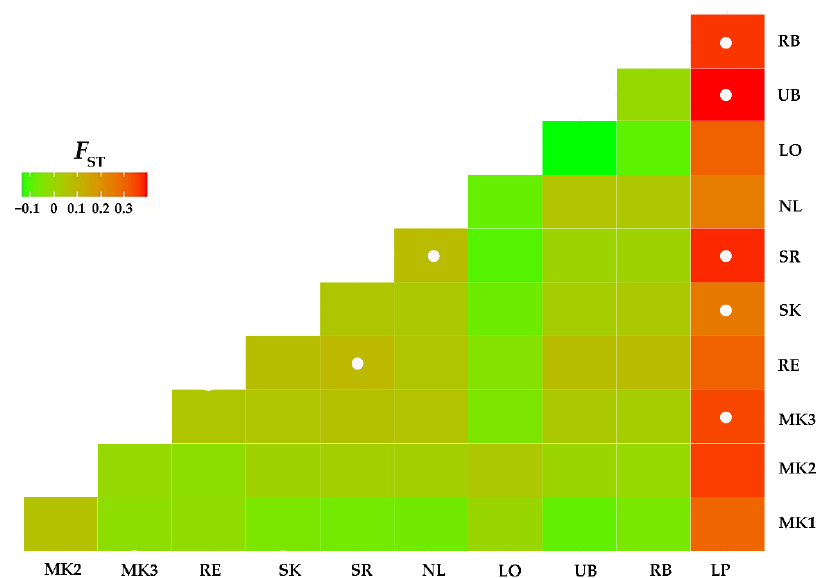
Figure 4. Heatmap for the pairwise F ST values between 11 populations of Culicoides mahasarakhamense in Thailand calculated based on COI sequences using the Kimura 2-parameter model. White circles indicate statistical significance after Bonferroni correction. Details of populations are provided in Table 1.